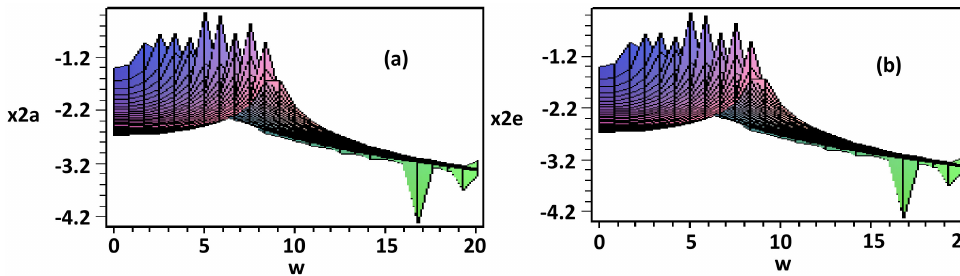
Figure 14. Evolution of x 2 (w) as a function of P 1 .: ( a ): Present approach. ( b ): Exact solution. Figure 15a,b show the evolution of the first and second circular natural frequencies, respectively, as a function of δ 1 (k 1 ).